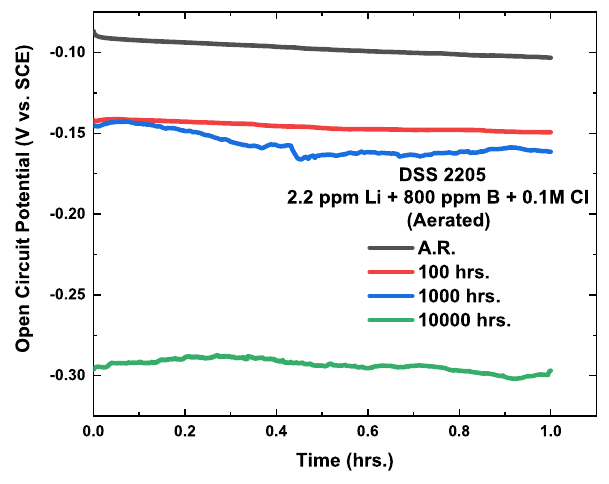
Fig. 8 Open-circuit potential as a function of time for the different thermal aging times in base + 0.1 M chloride-containing test solu-